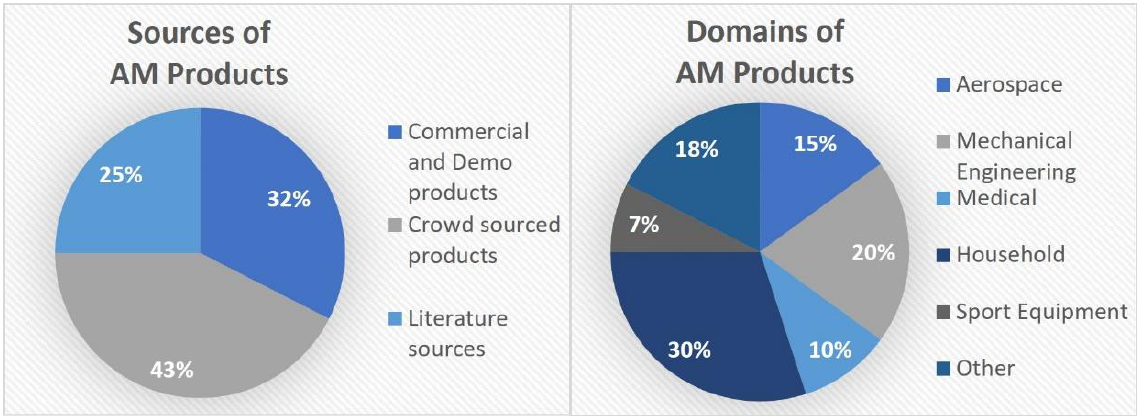
Figure 2. Sources and domains of analysed AM products.